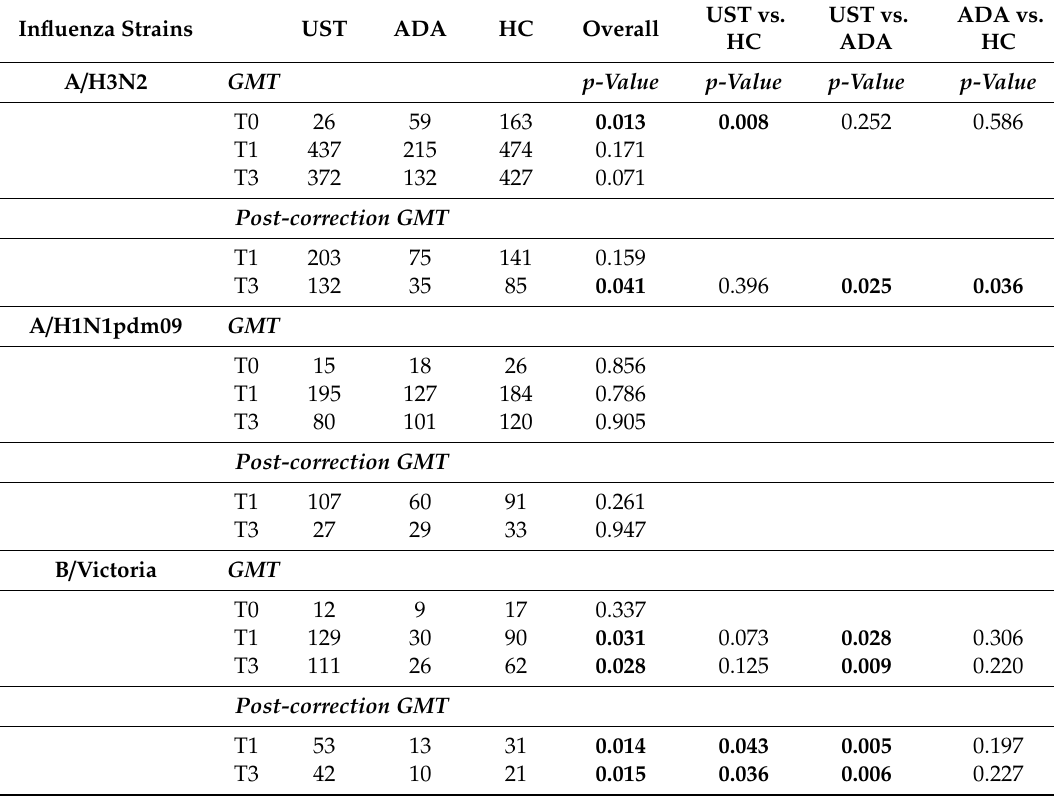
Table 4. Geometric mean antibody titers (GMT) per study group per time